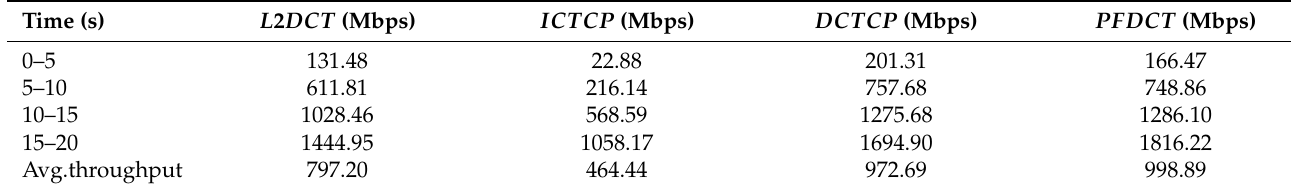
Table 3. Throughput comparison of multiple schemes in large-scale topology.